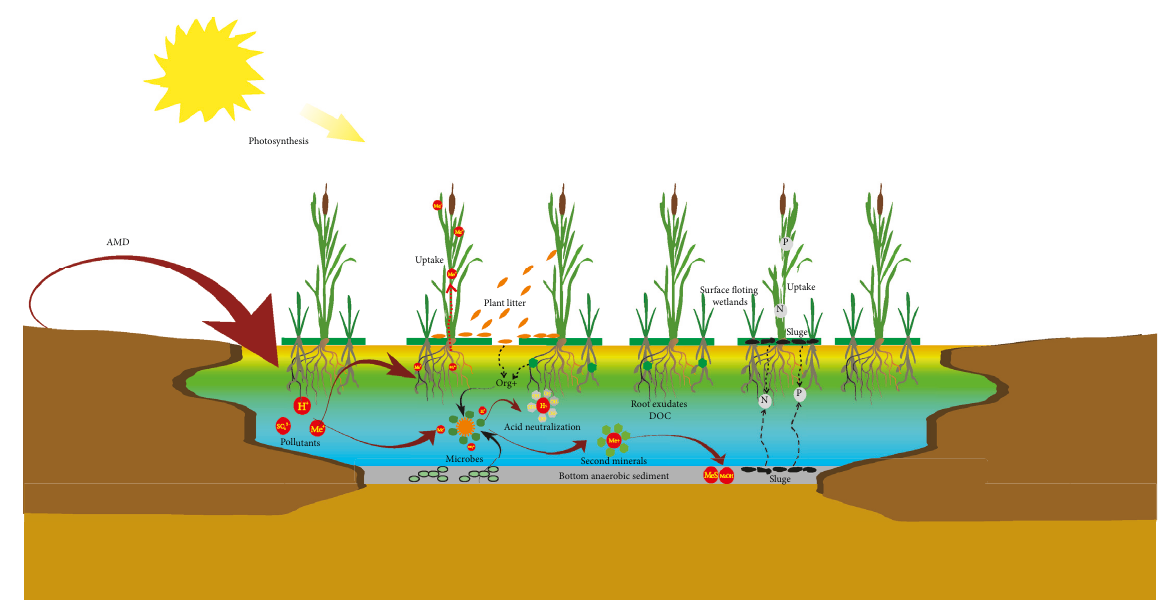
Figure 6: The possible remediated strategy of RW for AMD-contaminated